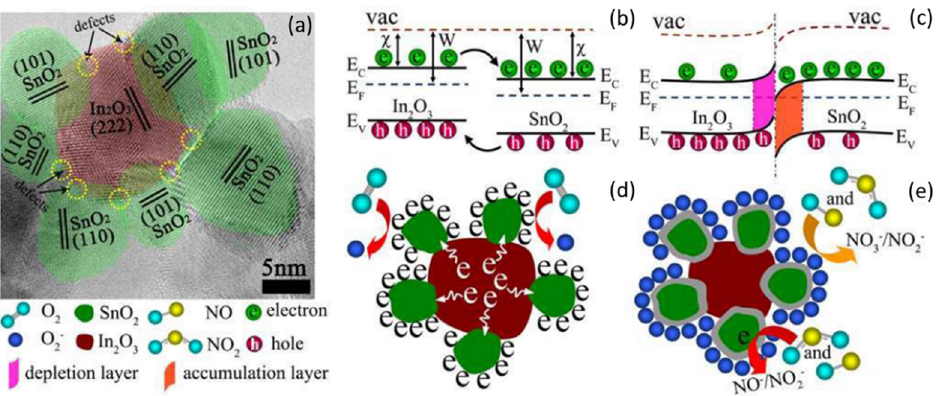
Figure 11. Sensing mechanisms of In 2 O 3 –SnO 2 nanoparticle (NP) composite heterojunctions. ( a ) High-resolution transmission electron micrograph of the composite. ( b , c ) Energy band alignment and bending before and after the junction, respectively. ( d , e ) Proposed mechanism for the perfor- mance enhancement based on the improved oxygen ionosorption caused by the accumulation of free electrons on the SnO 2 NPs from the In 2 O 3 NPs. Reproduced with permission from [55]. Copyright by The Royal Society of Chemistry